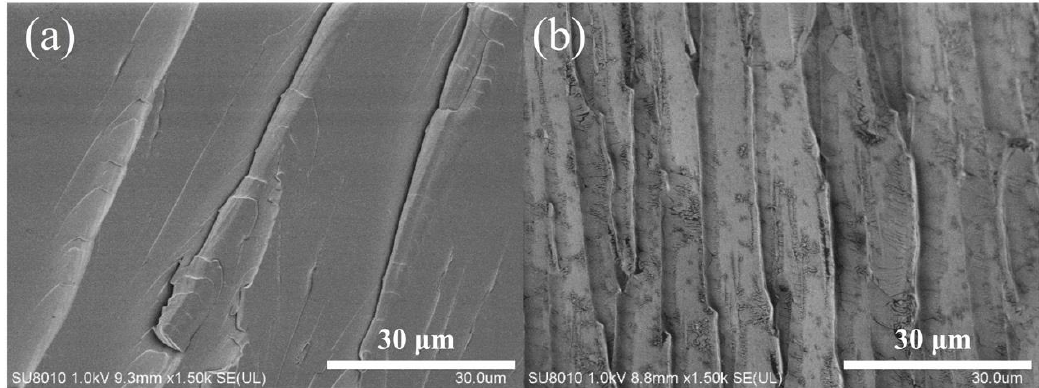
Figure 3. SEM images of the section morphology of ( a ) an epoxy resin coating with unmodified BFs and ( b ) an epoxy resin coating with BFs modified with 3‰ nano-SiO 2.